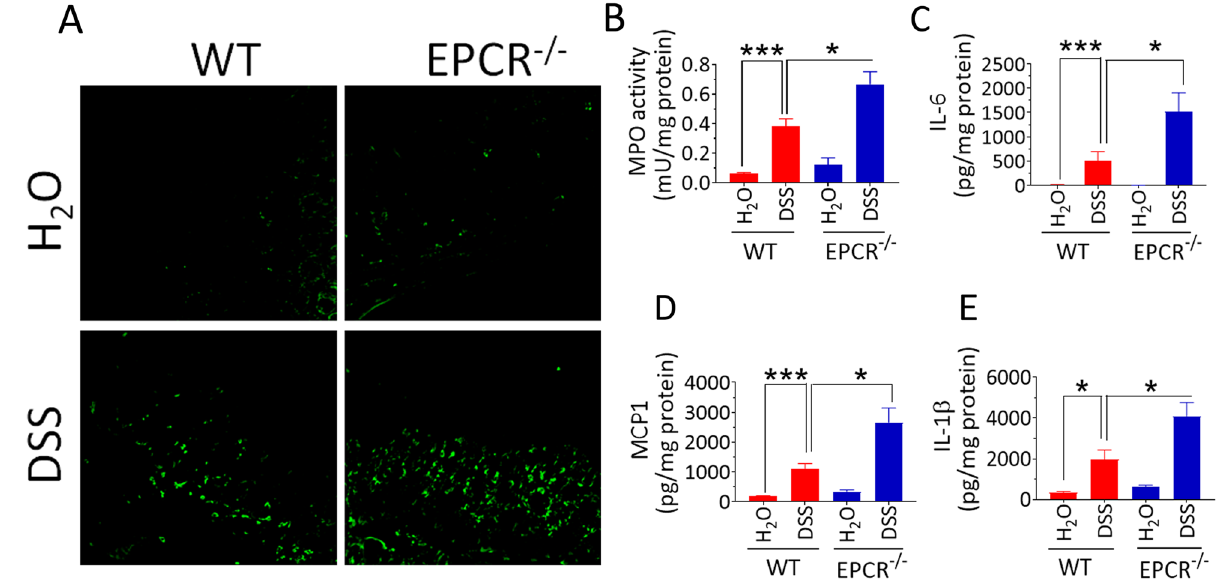
Figure 4. EPCR deficiency aggravates the DSS-induced macrophage infiltration and cytokine secretion in the colon. The colon tissues were collected from the control and DSS-treated mice and processed for tissue sectioning and preparing tissue extracts. ( A ) The colon tissue sections were stained with F4/80 antibody to identify macrophages by immunofluorescence microscopy. Green fluorescence spots indicate macrophages. Colon tissue extracts were used to measure myeloperoxidase activity ( B ), IL-6 ( C ), MCP1 ( D ), or IL-1ß ( E ). Data are the mean ± SEM of 2 independent experiments of 8 mice/group. * P < 0.05; *** P <